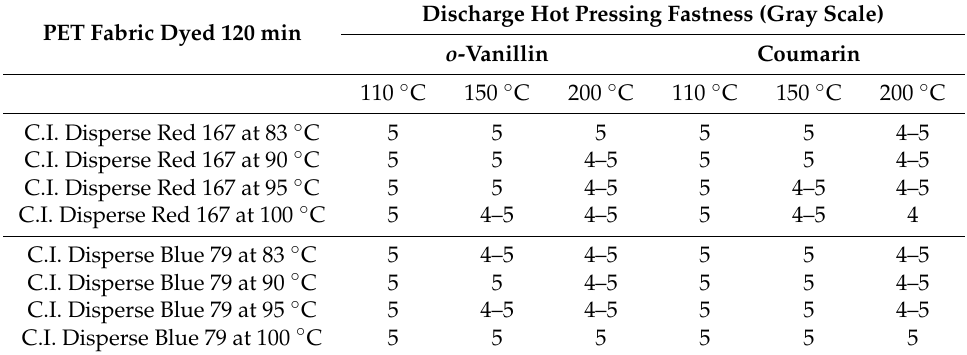
Table 8. Degradation hot pressing fastness.